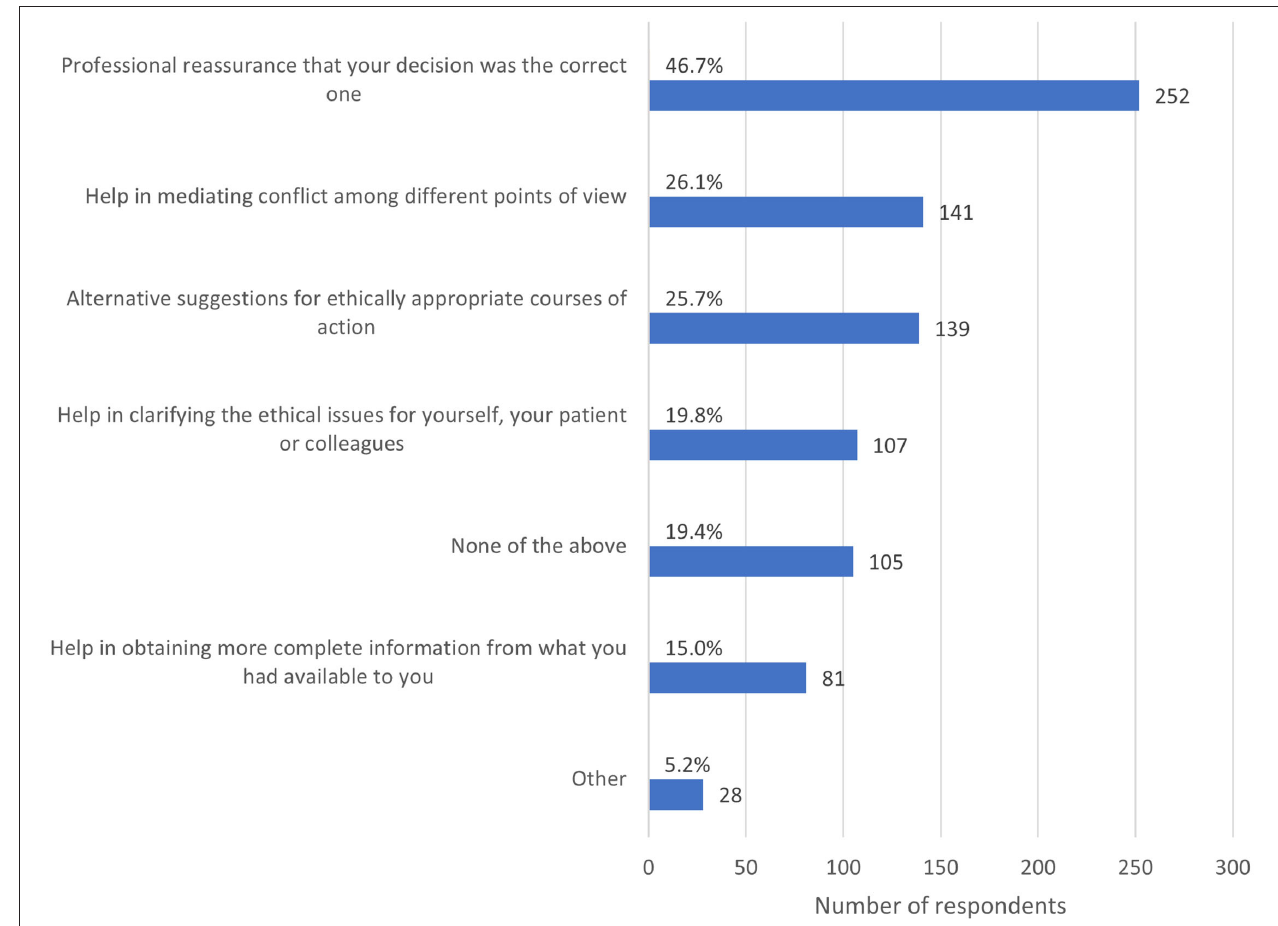
FIGURE 7 | Bar chart of the types of assistance respondents felt would have been useful in resolving the most recent ethically challenging situation they encountered, based on the responses of 540 veterinarians, animal health technicians and veterinary nurses, surveyed between May and July in 2020. Note that respondents could select multiple